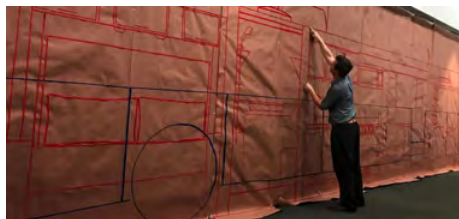
Figure 3. adesign student using a 1:1 scale drawing to better understand their